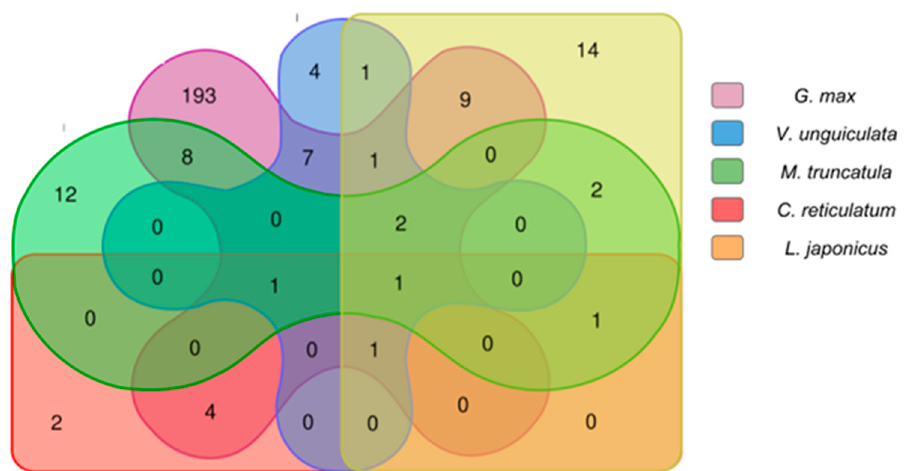
Figure 5. Count of copaíba lncRNAs aligned to each Fabaceae transcriptome with BLASTN (90% identity): This diagram shows the amount of copaíba lncRNA aligned to the transcriptome of each species, segregated by a color pattern indicated on the legend. In the colored overlapped area are the transcripts which were aligned to more than one species transcriptome, and its respective amount. There are only five species shown in this diagram, for illustration purposes we left out P . vulgaris .